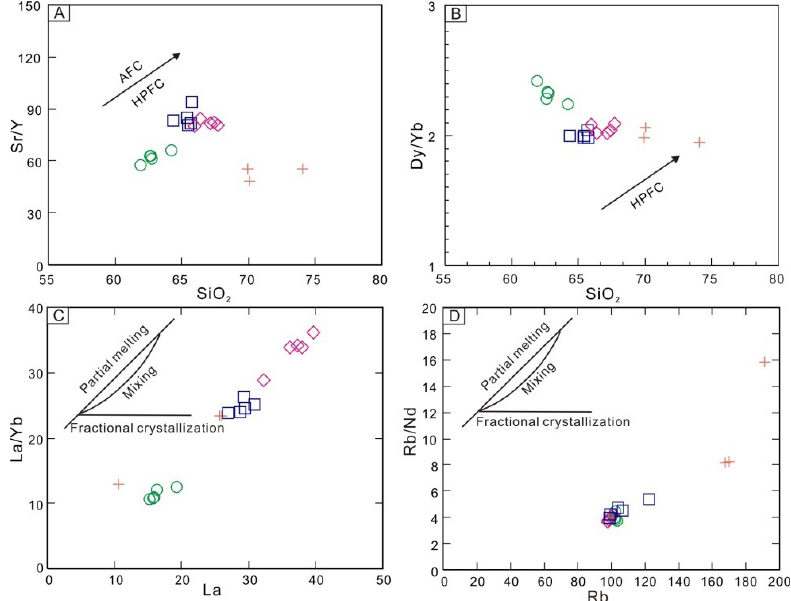
Figure 11. ( A ) Sr/Y vs. SiO 2 , ( B ) Dy/Y vs. SiO 2 , ( C ) La/Yb vs. La, and ( D ) Rb/Nd vs. Rb diagrams for the Pulang porphyry intrusions. Symbols are as in Figure 10.